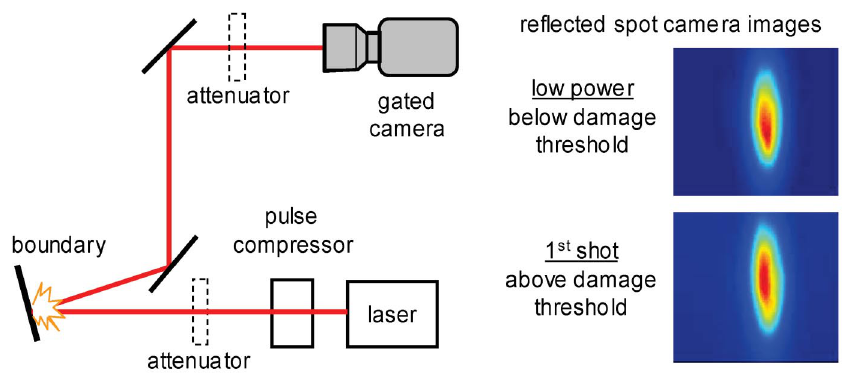
FIG. 12. (Color) The setup for the reflectance measurement from the gold-coated Kapton tape above damage threshold. The reflected spot images below damage threshold and the 1st reflected pulse above damage threshold are